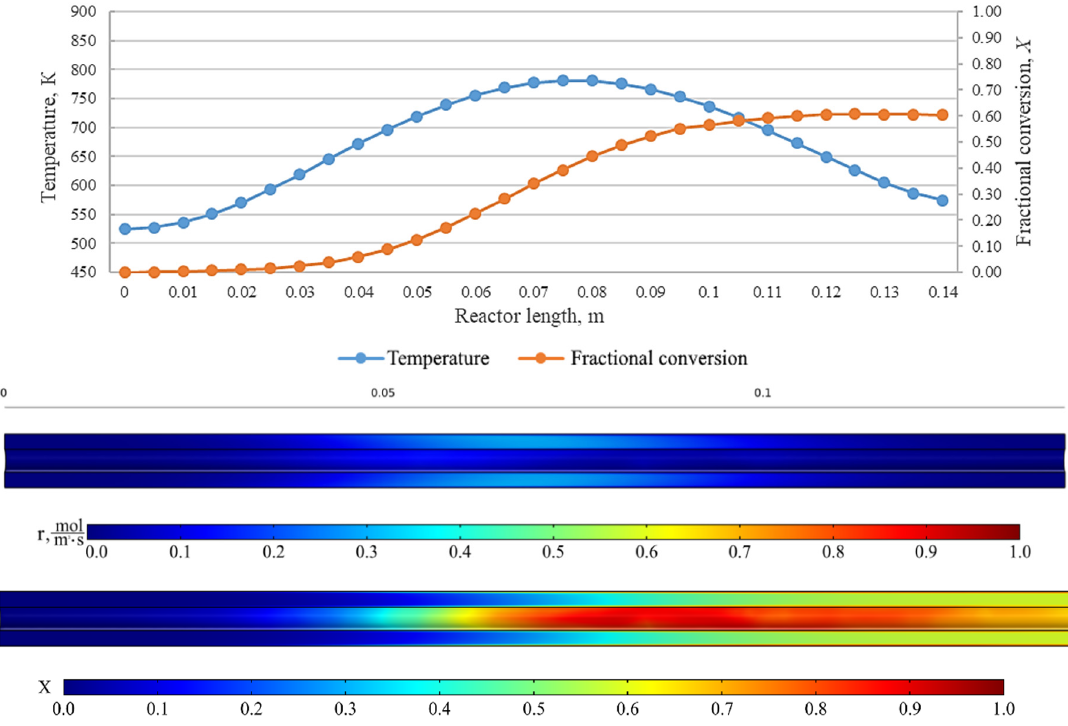
Figure 11. From top to bottom: temperature and fractional conversion curves, profiles of the reaction rate and fractional conversion along the reactor length for the experiment BnOm_500_43 (Tmax = 500 °С , V = 1.5 L / min).